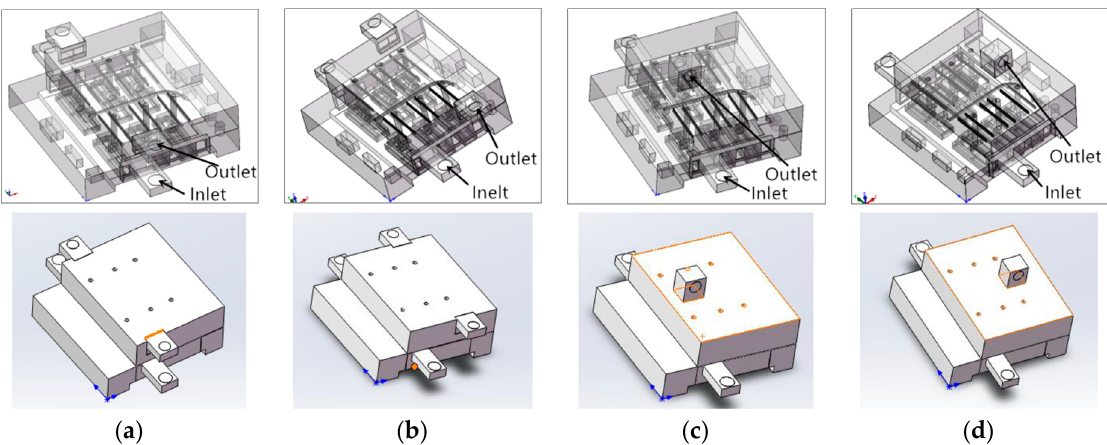
Figure 4. Four different arrangements of the exhaust vent: (a) left side arrangement, (b) left-right sides arrangement, (c) left-side and left-roof arrangement, and (d) left-side and right-roof arrangement.